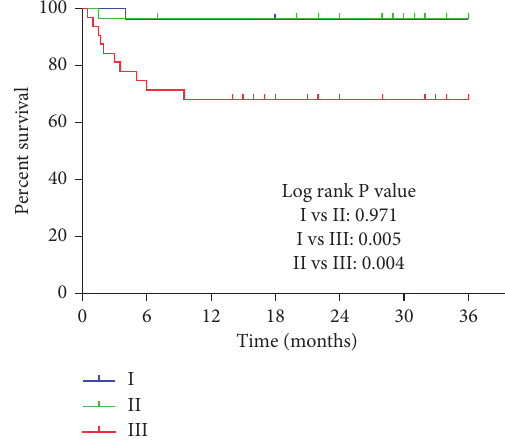
Figure 4: Prediction of clinical outcomes of main classification (survival curve).